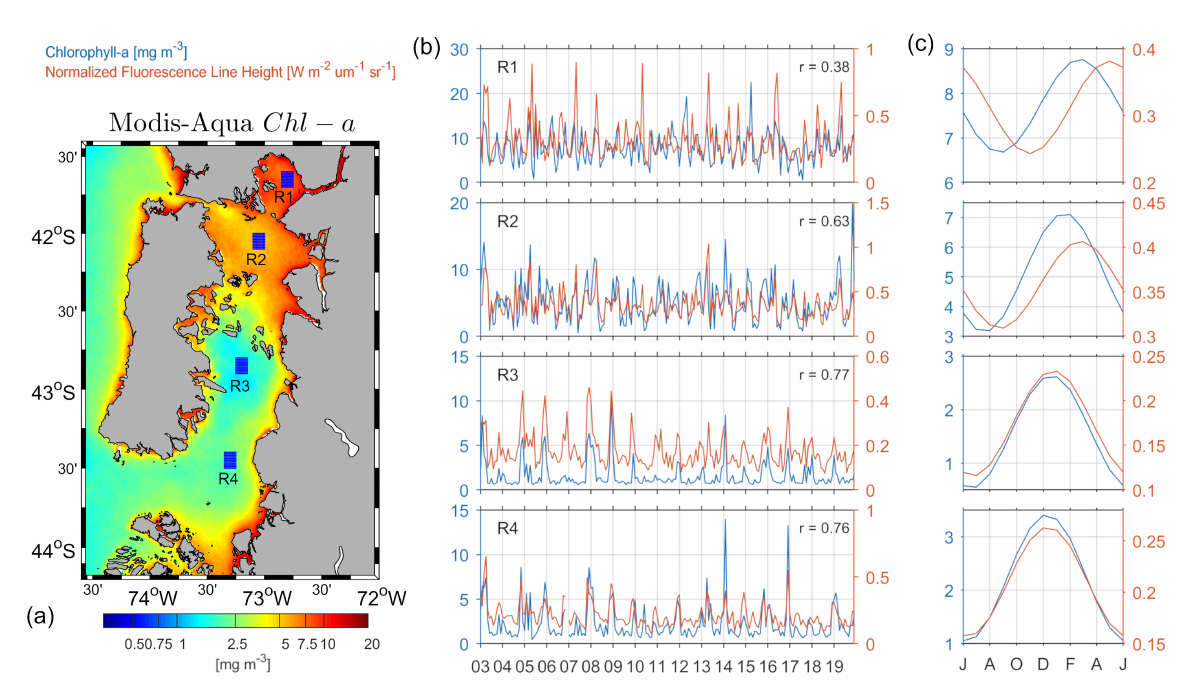
Figure 4. Temporal variability of Chl-a (blue curves) and nFLH (red curves) at 4 locations (R1–R4, shown as blue boxes in ( a ) along the Inner Sea of Chiloé (ISC). The interannual time series are presented in ( b ), whereas the corresponding annual cycles are shown in ( c ); r-values correspond to linear correlation coefficients. The average Chl-a is color-coded in ( a ). Notice that the annual cycles start from June in ( c ). For reference of locations, see Figure